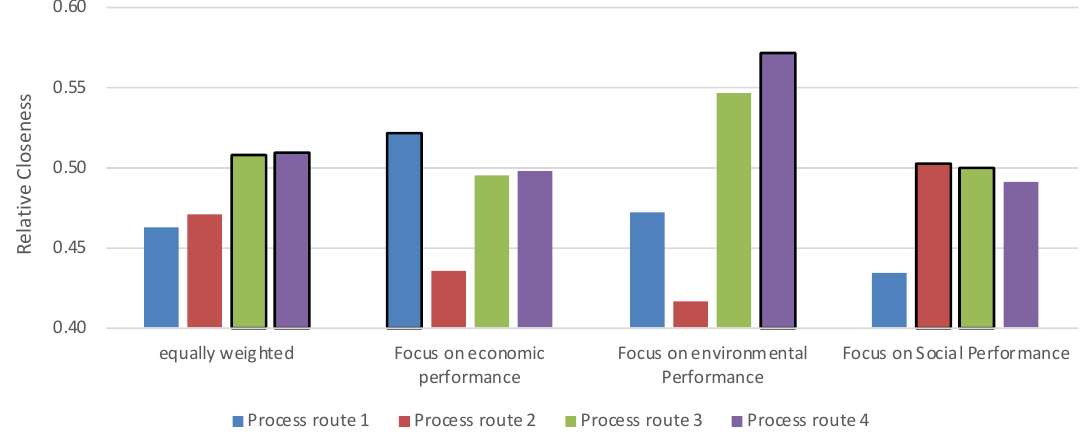
Figure 15. Relative closeness with changing weighting factors depending on where the focus of analysis is for the case of medium demand. Outlined in black, the process routes that are outperforming others for each scenario.